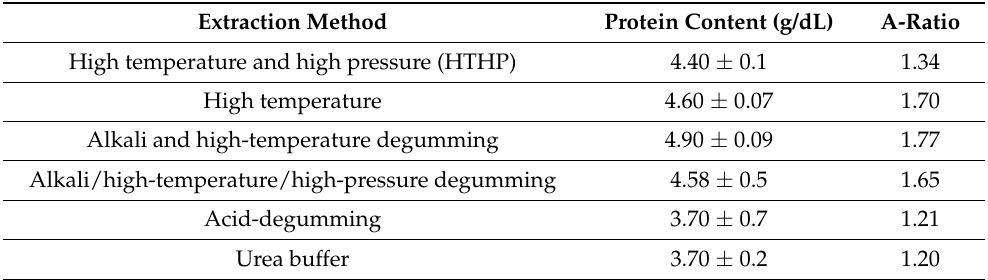
Table 1. Protein content assessment using different extraction